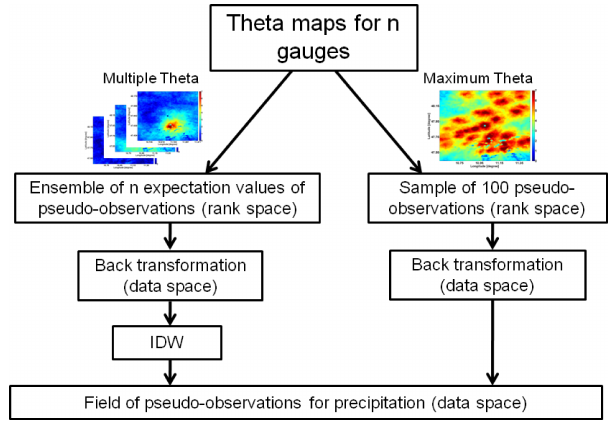
Fig. 3: Overview over the Copula based interpolation meth- Fig. 3. Overview over the copula-based interpolation methods. ods.